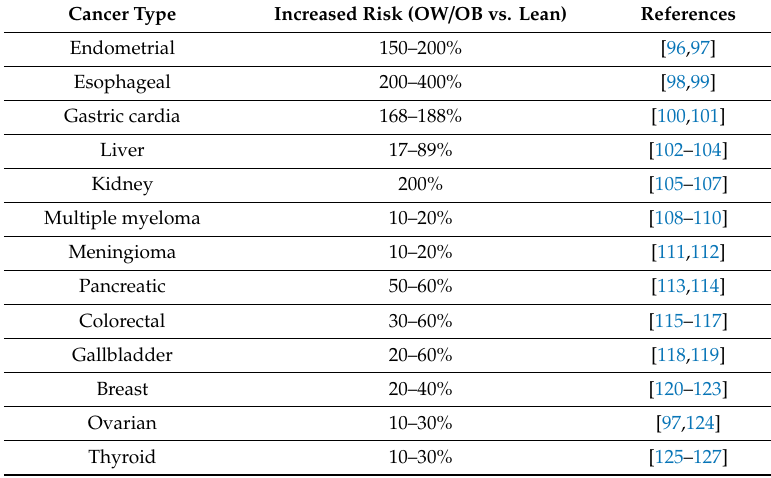
Table 3. Increased risk for 13 cancer types correlated to overweight / obesity (% increased risk OW / OB vs. lean) and their corresponding epidemiological